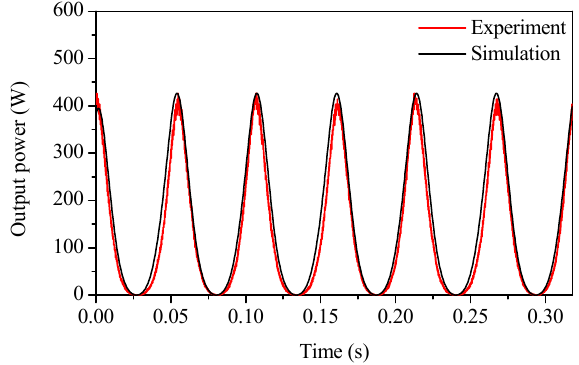
Figure 12. Output power under full load condition ( v rms = 0.25 m/s).